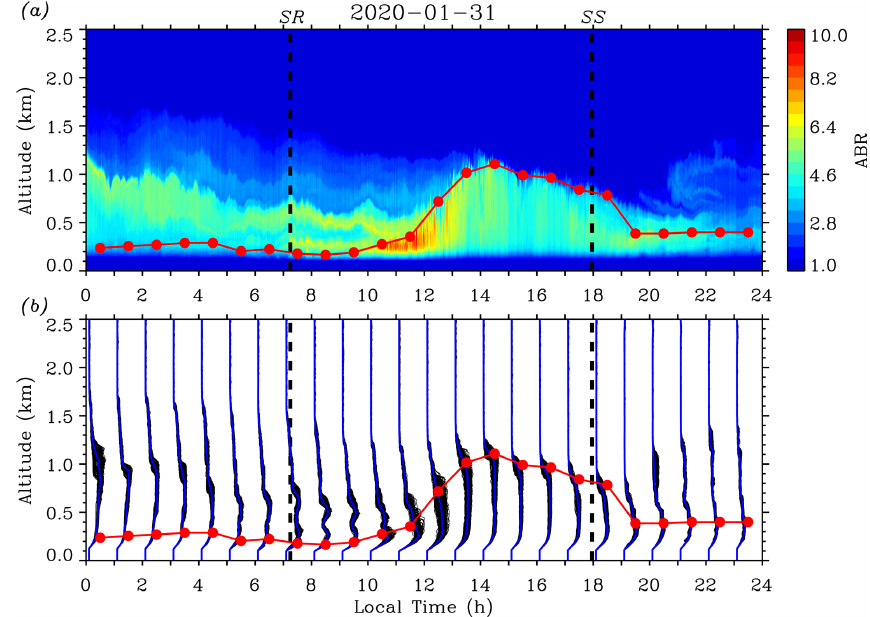
Figure 4. (a) Contour plot of the ABR on 31 January 2020. (b) Over-plots of ABR profiles (thin black lines) in each 1h time interval and the hourly mean ABR profile (blue lines). SR and SS times are indicated by thick black dashed lines. Red solid circles represent the hourly mean ABL depth retrieved by using the variance method and the red line indicates the diurnal evolution trend of the ABL